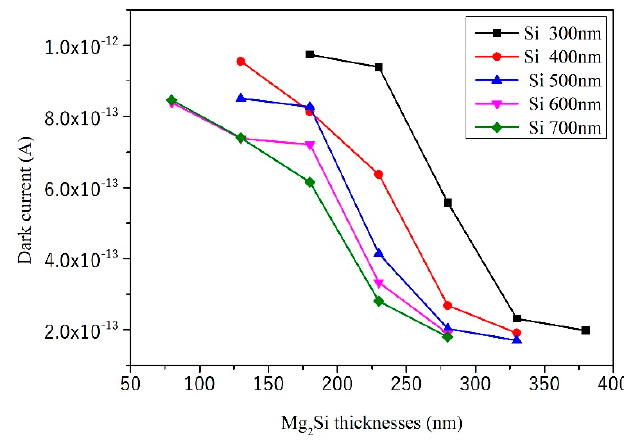
Figure 5. The effect of thicknesses on the dark current.